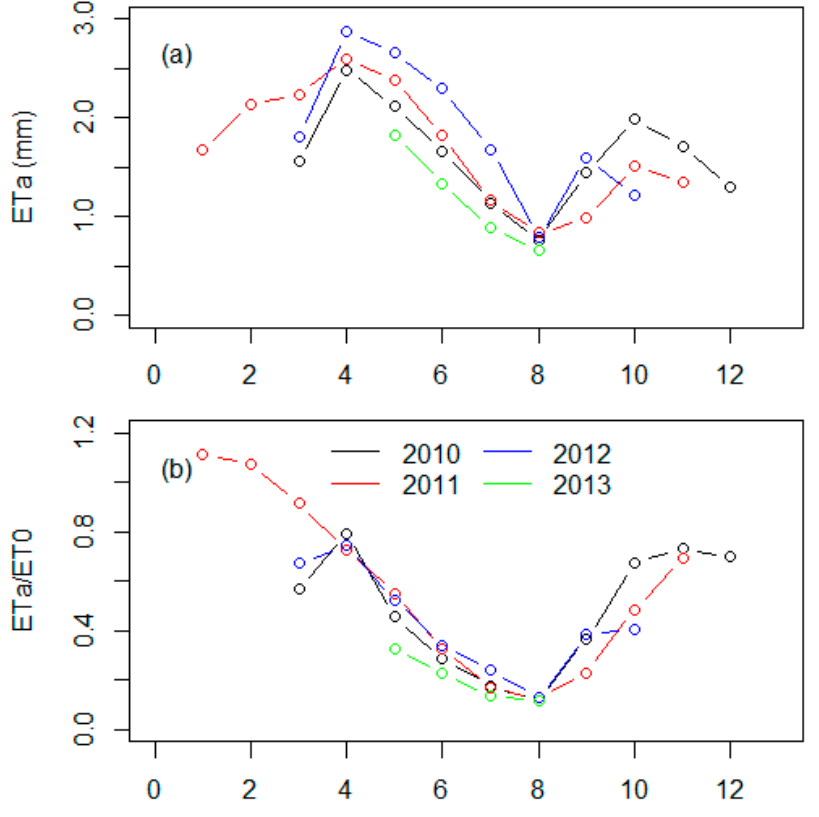
Figure 6. Seasonal evolution of the actual evapotranspiration at monthly time scale, during the four years of the experiment. ( a ) Actual evapotranspiration ETa; ( b ) Ratio of actual evapotranspiration to reference evapotranspiration ET 0